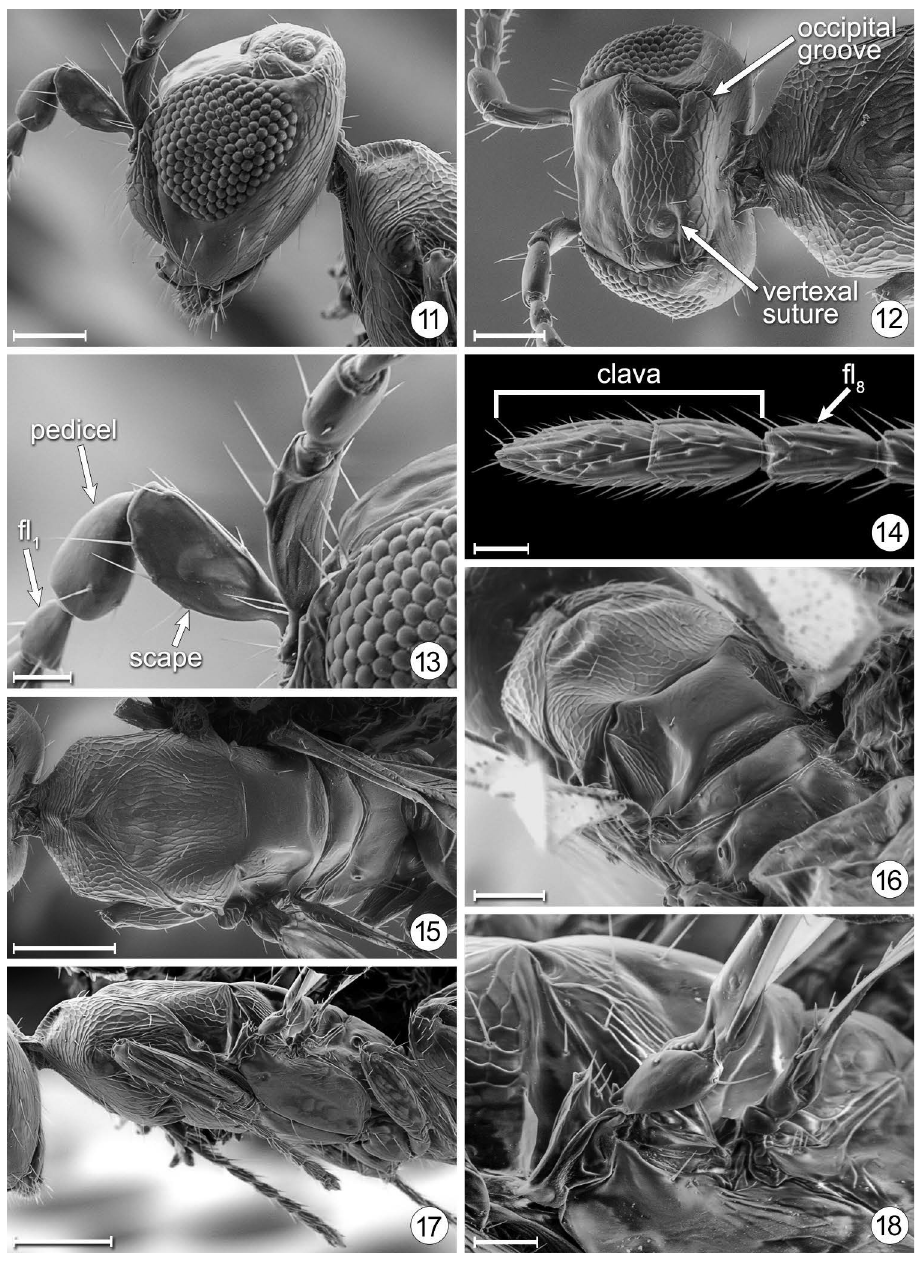
Figures 11–18. Eustochomorpha haeckeli , female. 11 head + prothorax, lateral 12 head + prothorax, dorsal 13 base of antenna, lateral (right antenna) and ventral (left antenna) 14 apex of antenna 15 mesosoma, dorsal 16 mesosoma, posterolaterodorsal 17 mesosoma, lateral 18 base of wings + mesosoma, lateral (medial portion). Scale bar for 11, 12, 16 = 50 μm; 13, 14, 18 = 20 μm; 15, 17 = 100